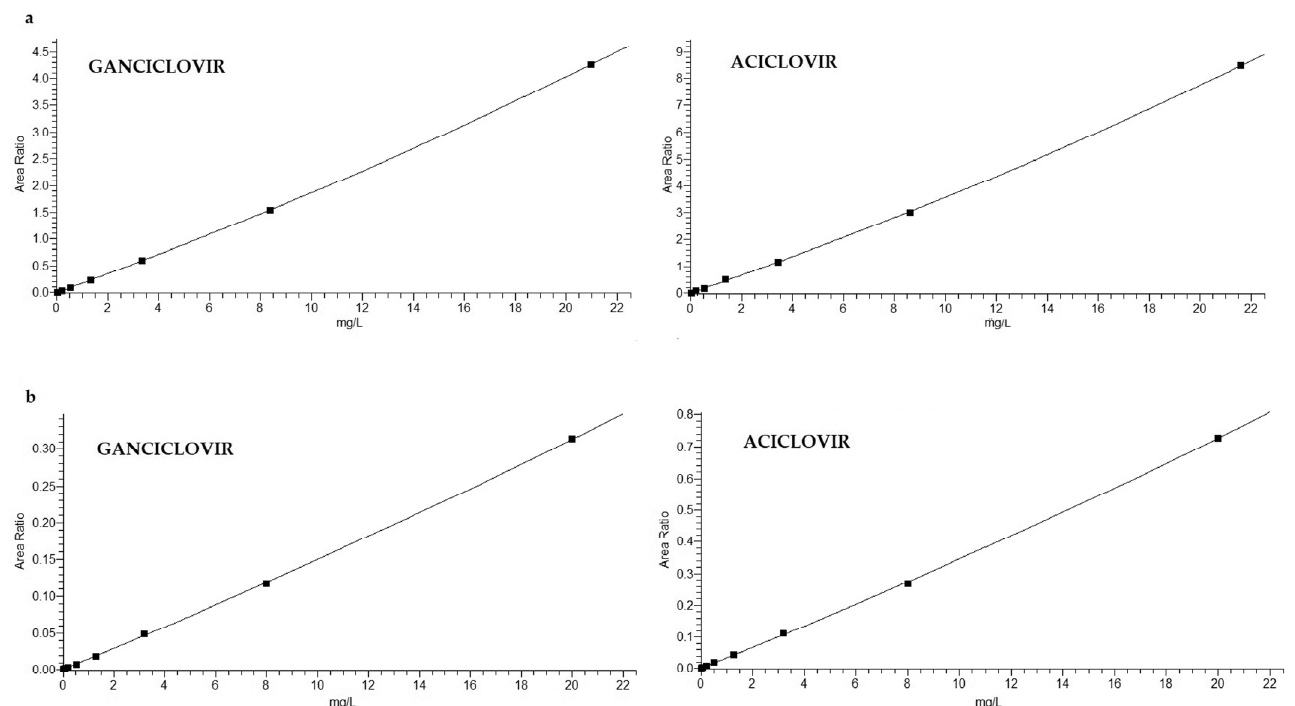
Figure 1. The mean calibration curves (9 point calibration curve) of ganciclovir and aciclovir ranging from 0.01 to 20 mg/L in plasma (panel a ) and in DPS (panel b ).